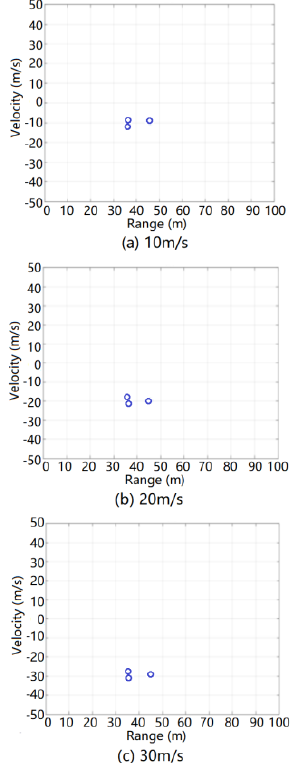
Figure 19. Results of ground clutter after constant false-alarm rate (CFAR) detection and processing during simulation.